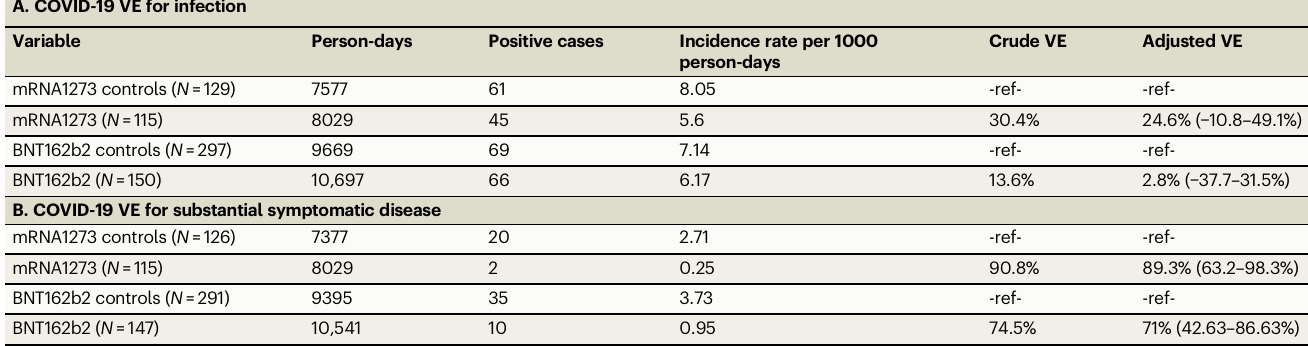
Table 2 | COVID-19 Vaccine ef fi cacy for infection and substantial symptomatic